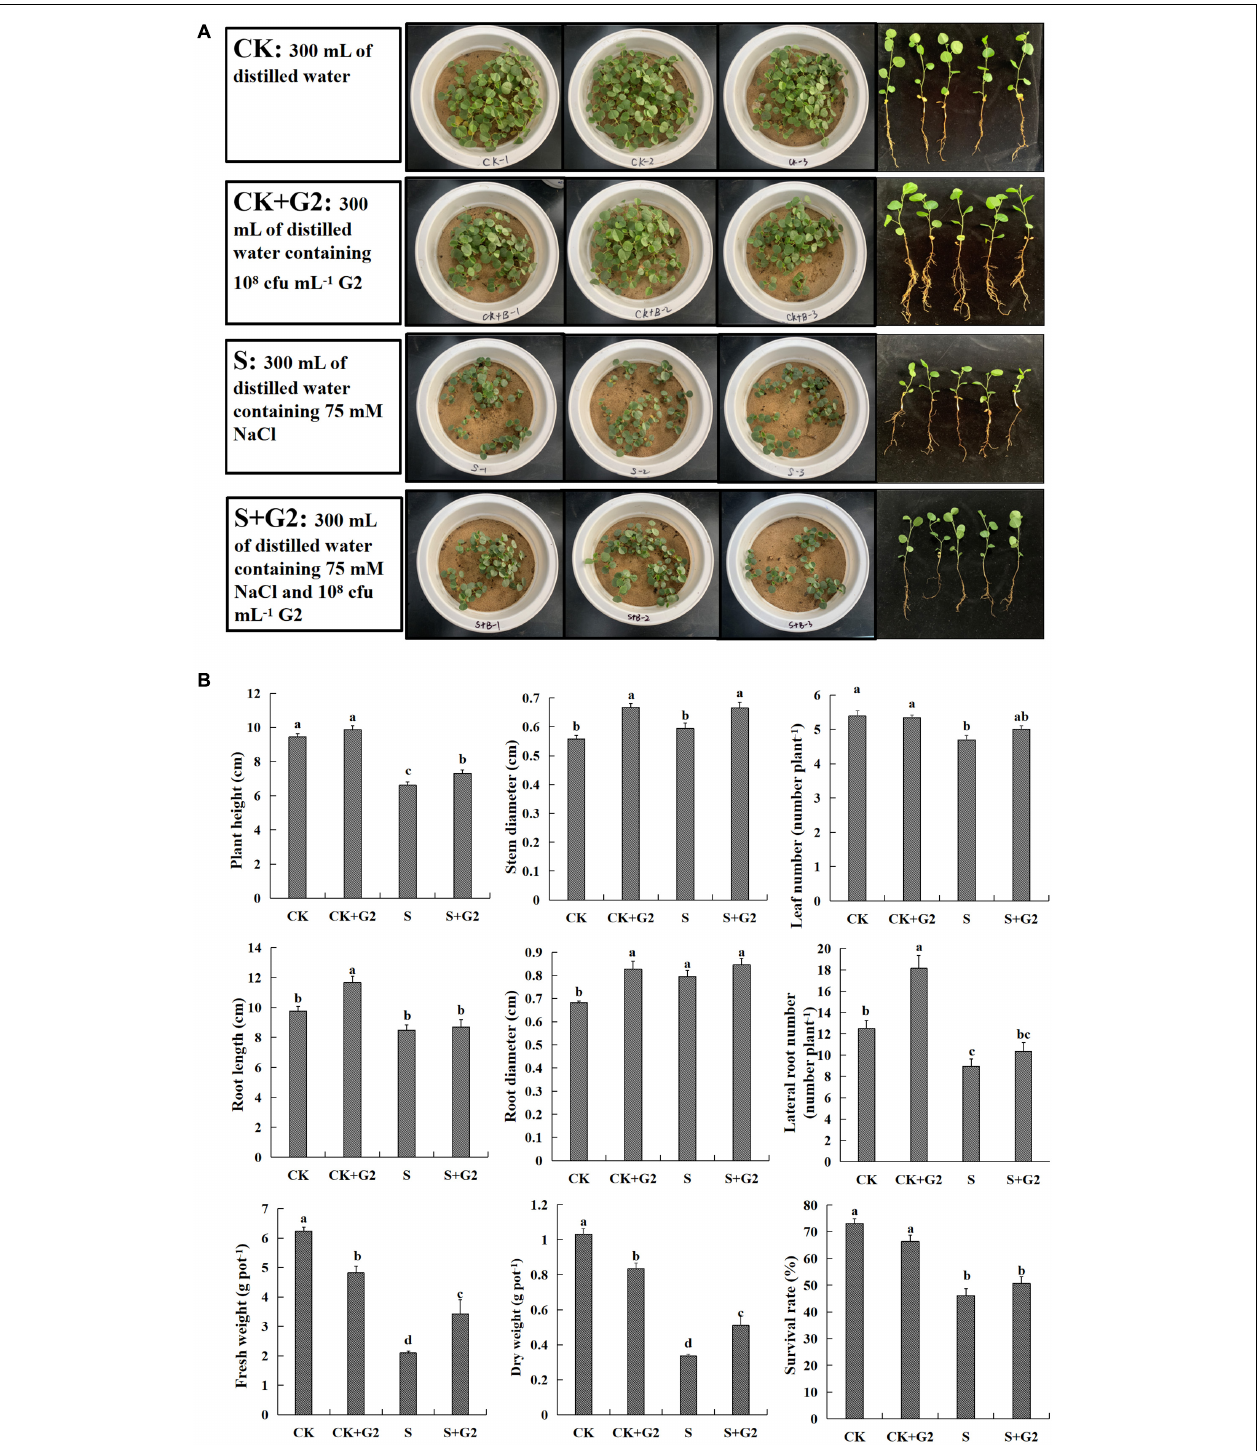
FIGURE 1 | (A) A part of the experiment layout of Glycyrrhiza uralensis Fisch. seedlings grown in control and salt stress conditions without or with Bacillus cereus G2. (B) Effects of B. cereus G2 on growth parameters of G. uralensis seedlings under control and salt stress conditions. CK, control group; S, salt stress group; CK + G2, control combined with the G2 group; S + G2, salt stress combined with the G2 group. The different letters within the different treatments in the same parameter indicate the significant difference at the 0.05 level. Values are means ± SE ( n = 3).